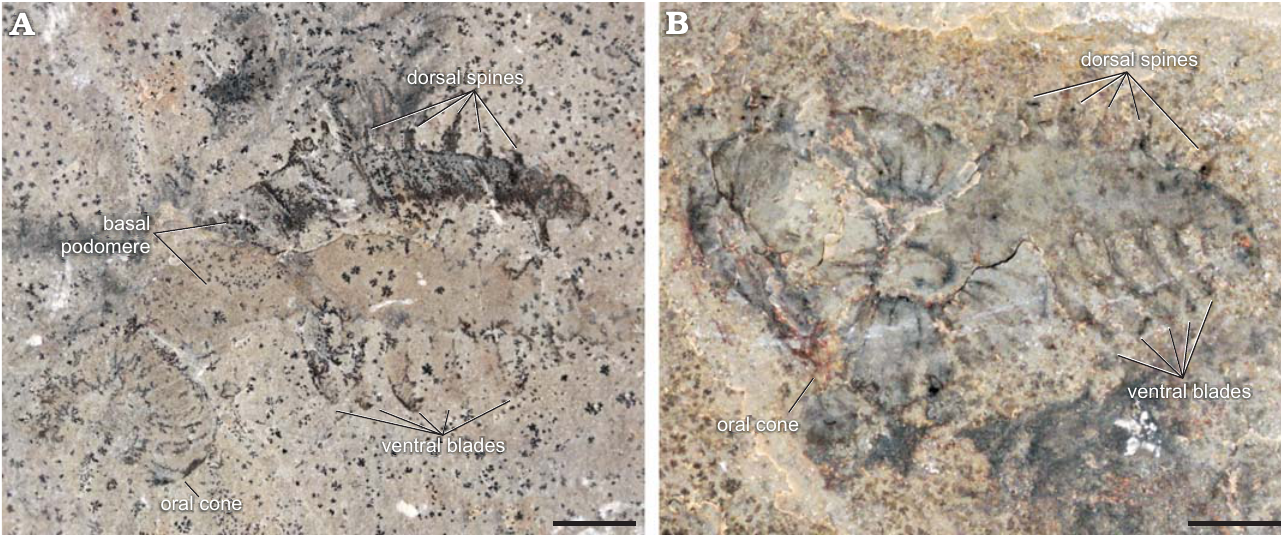
Fig. 2. The radiodontan Stanleycaris hirpex gen. et sp. nov. from the Stephen Formation (Cambrian Series 3, Stage 5), British Columbia, Canada. Frontal